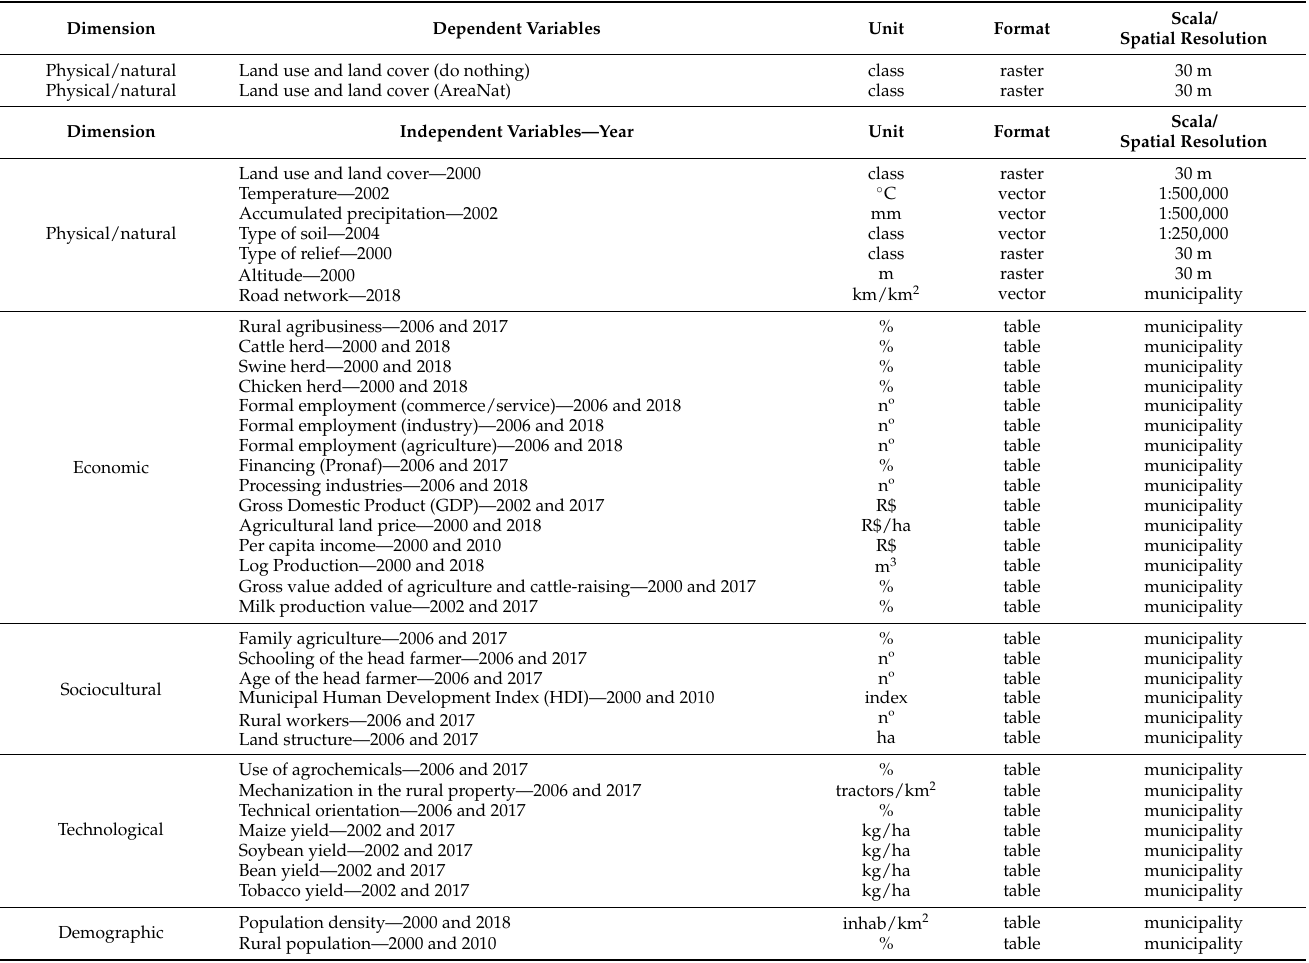
municipality Cattle herd—2000 and 2018 % municipality Swine herd—2000 and 2018 municipality Chicken herd—2000 and 2018 municipality Formal employment (commerce/service)—2006 and 2018 municipality Formal employment (industry)—2006 and 2018 municipality Formal employment (agriculture)—2006 and 2018 municipality Financing (Pronaf)—2006 and 2017 municipality Processing industries—2006 and 2018 municipality Gross Domestic Product (GDP)—2002 and 2017 municipality Agricultural land price—2000 and 2018 R$/ha municipality Per capita income—2000 and 2010 municipality Log Production—2000 and 2018 municipality Gross value added of agriculture and cattle-raising—2000 and 2017 municipality Milk production value—2002 and 2017 municipality municipality Schooling of the head farmer—2006 and 2017 municipality Age of the head farmer—2006 and 2017 municipality Municipal Human Development Index (HDI)—2000 and 2010 municipality municipality Rural workers—2006 and 2017 ha municipality Land structure—2006 and 2017 municipality Mechanization in the rural property—2006 and 2017 tractors/km 2 municipality Technical orientation—2006 and 2017 municipality Maize yield—2002 and 2017 kg/ha municipality Soybean yield—2002 and 2017 kg/ha municipality Bean yield—2002 and 2017 kg/ha municipality Tobacco yield—2002 and 2017 kg/ha municipality inhab/km 2 municipality Rural population—2000 and 2010 %